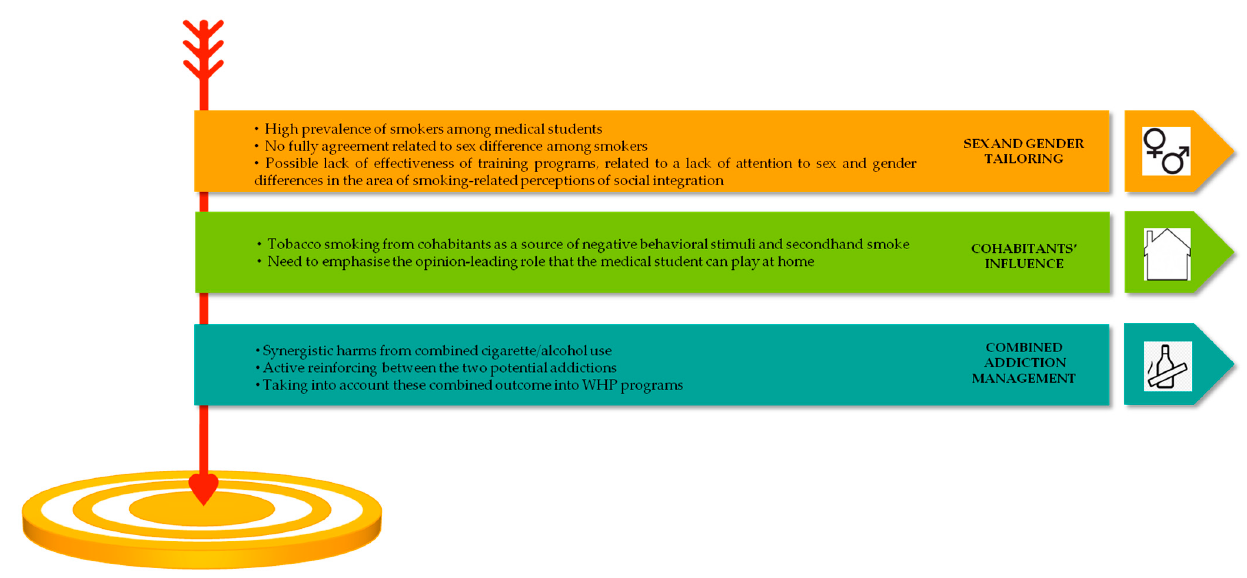
Figure 3. Insight for workplace health promotion programmes related to smoking dissuasion. A key